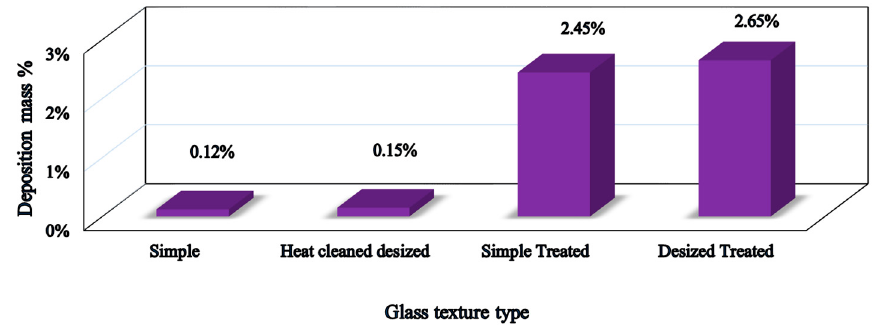
Figure 9. Effect of glass fiber surface treatment on deposition mass of CNTs in EPD.